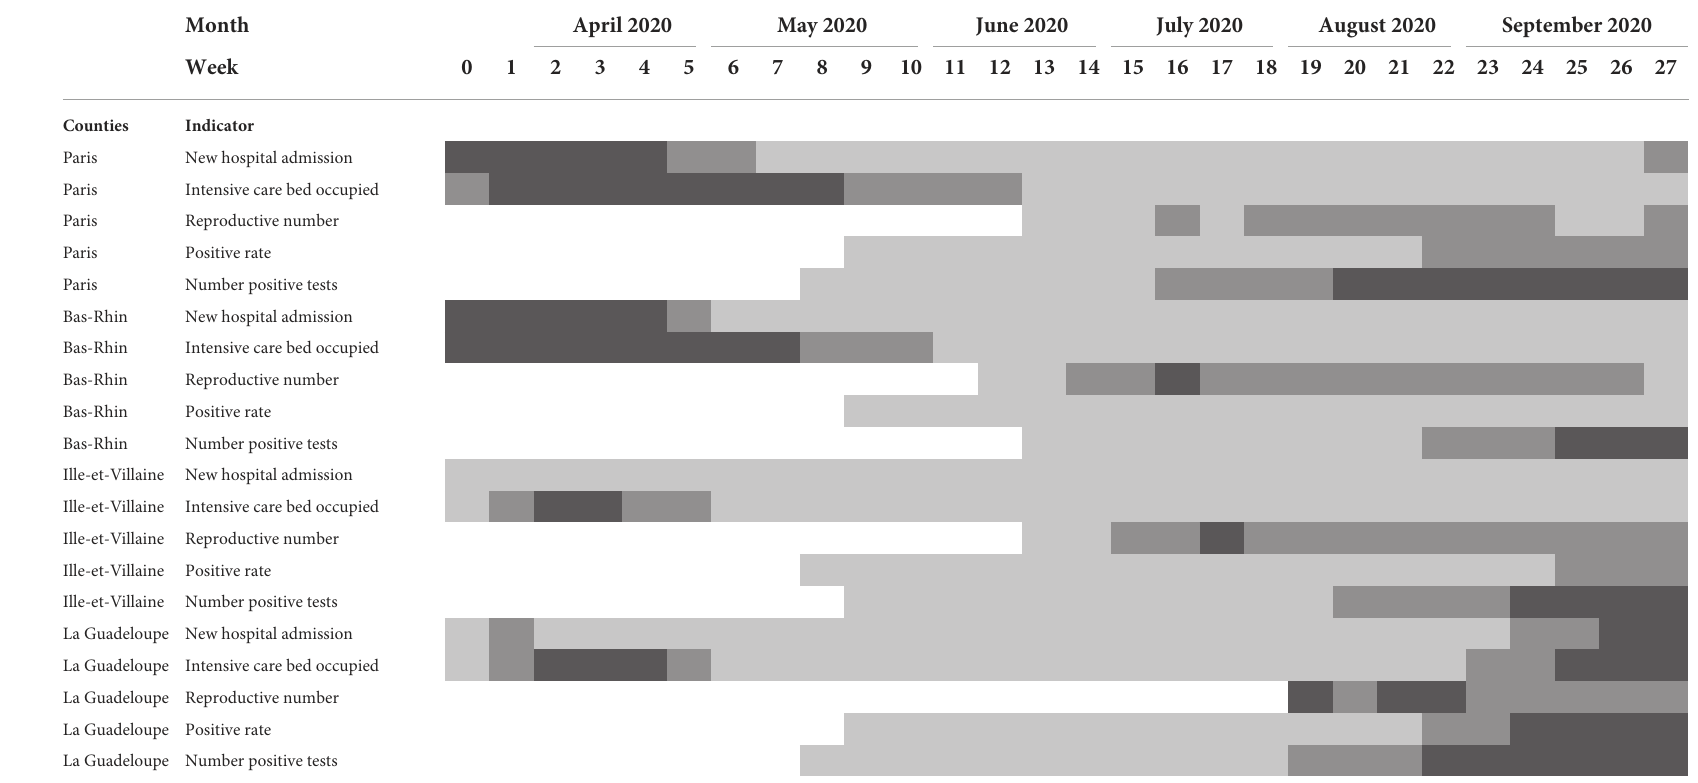
TABLE 1 Comparison of the different indicators according to time for four different types of